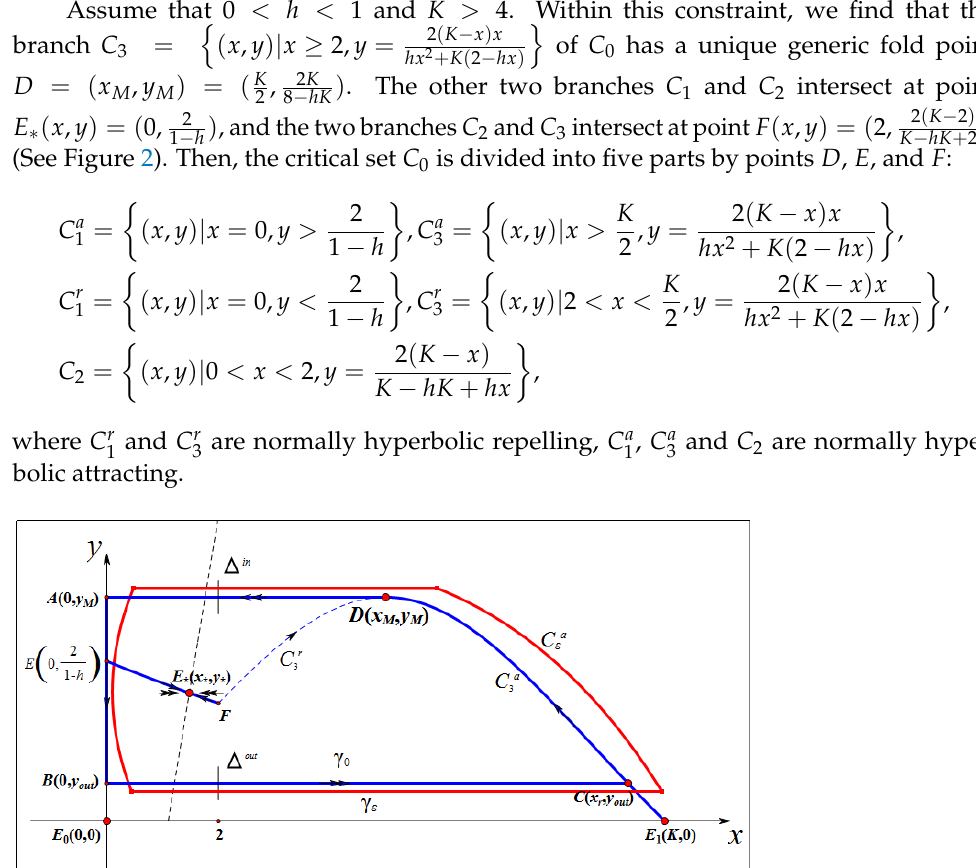
and repelling part C r . The black dotted 3 3